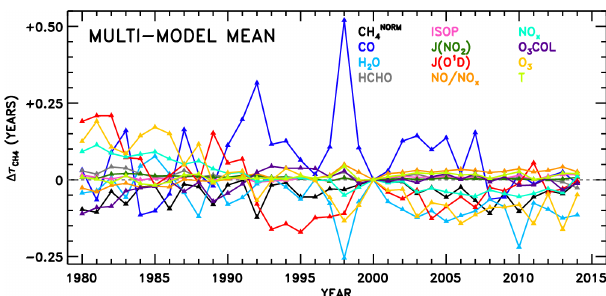
Figure 8. Same as Fig. 7 but the average across all eight models, except filtered to remove NN results for individual months and years during which NN performance is poor, as detailed in the text.